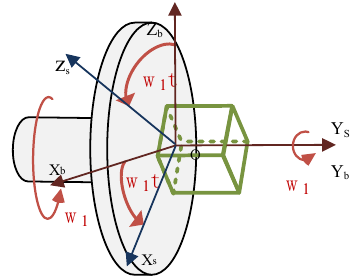
Figure 1. Microinertial measurement schematic diagram of uniaxial rotation modulation principle.